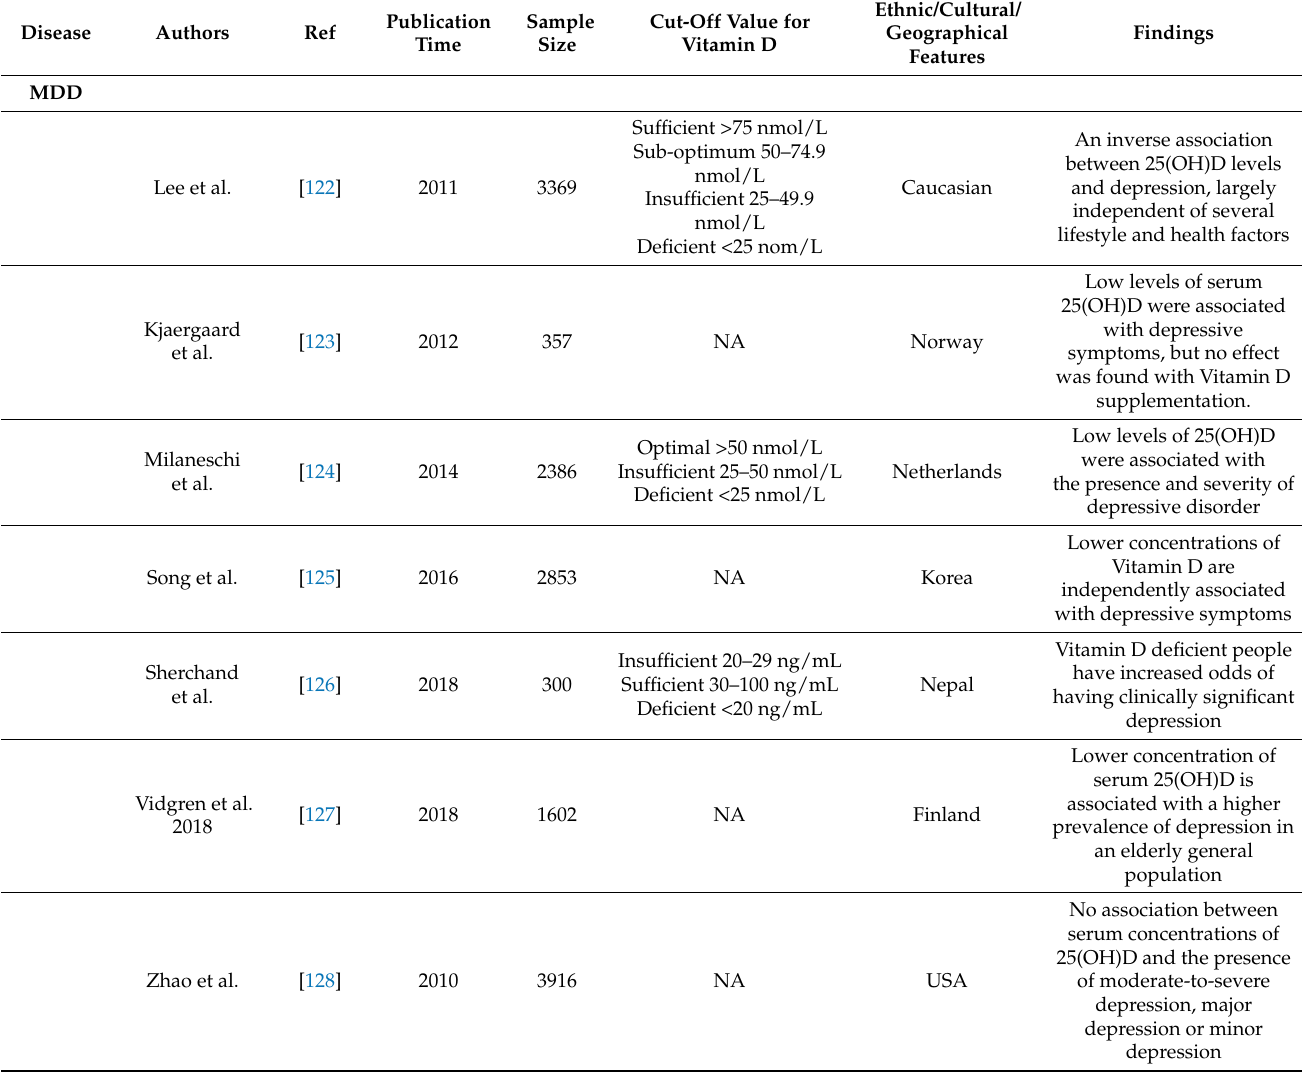
Table 2. Major findings from the observational studies evaluating Vitamin D serum levels in psychi- atric